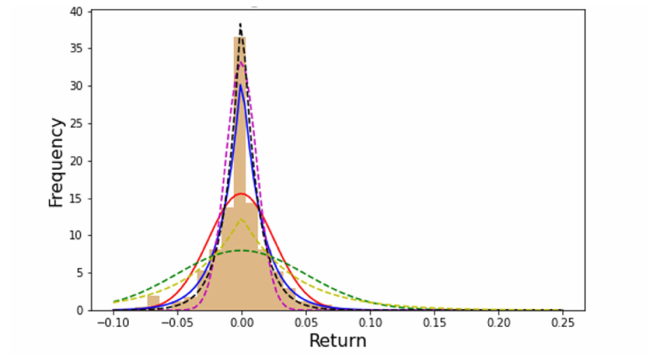
Fig. 1 The Histogram of NFCX Return